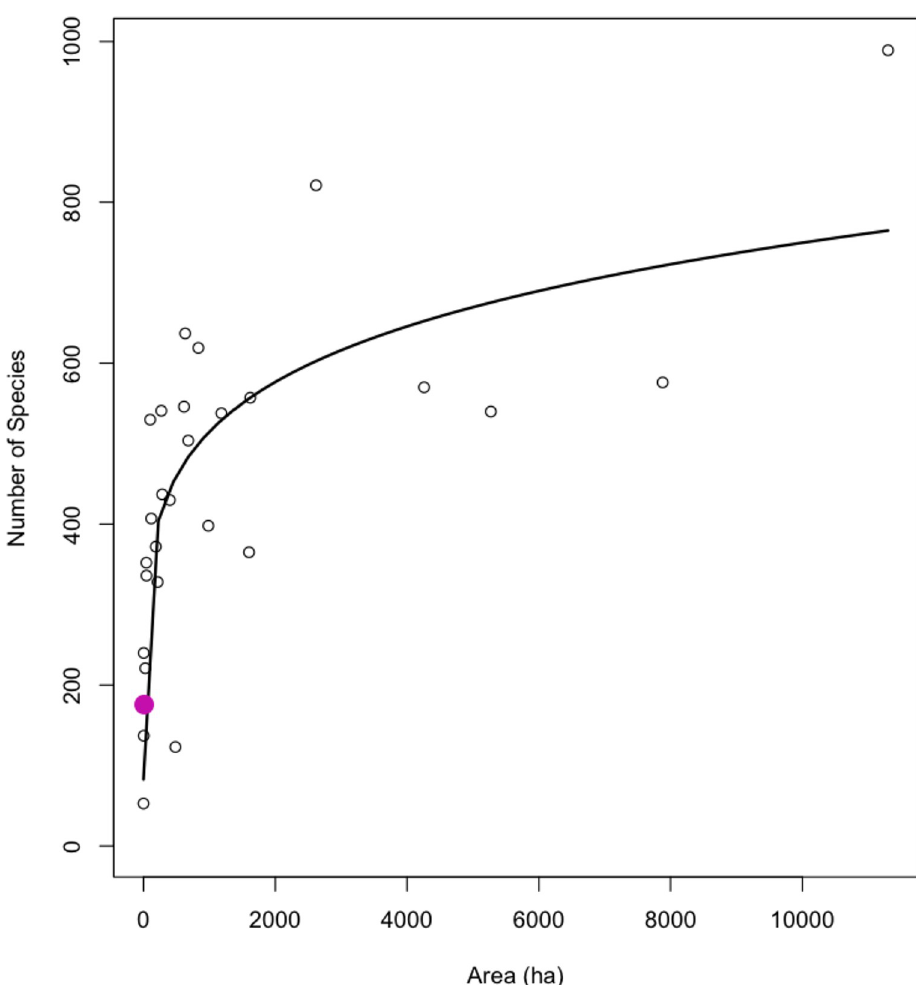
Fig 5. Species-area relationship of all 28 comparison floras (CF1 through CF28, labeled; S1 Table). The Garden City Terminal survey at the Port of Savanah (CF28) is the pink circle, and all 27 other comparison floras as open